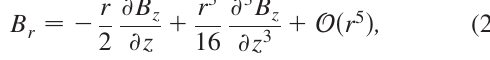
ffiffiffi p 8 for Gaussian, elliptical,